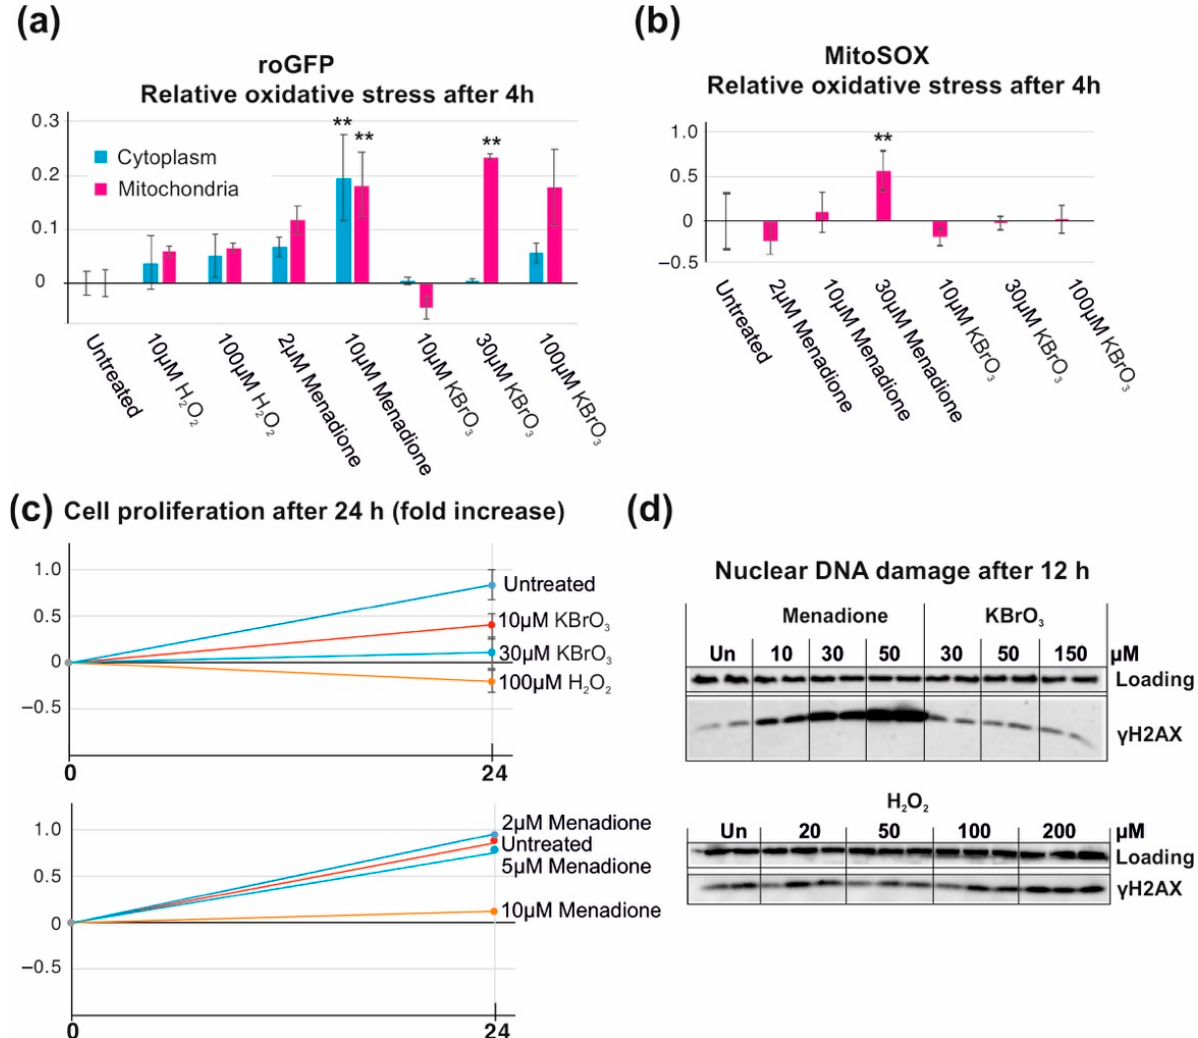
Figure 1. Oxidative stress, nuclear DNA damage, and cell proliferation after menadione, KBrO 3 , and H 2 O 2 exposure. ( a ) Cytoplasmic and mitochondrial oxidative stress in HEK293T cells measured as a relative change in the roGFP fluorescence intensity after 4 h treatment with different oxidant concentrations. Measurements normalized against the untreated samples (0-fold change). ( b ) Mitochondrial superoxide levels in HEK293T cells after 4 h treatment with different oxidant concentrations. Measurements normalized against the untreated samples. ( c ) Cell proliferation measured as fold increase in cell number during 24 h exposure to different oxidant concentrations. Only selected concentrations shown to demonstrate the effective range of the chemicals. ( d ) Activation of nuclear DNA damage signaling—phosphorylation of histone H2AX ( γ H2AX)—in HEK293T cells after 12 h treatment with different oxidant concentrations. ** p < 0.01 ANOVA/Tukey, compared with the untreated control. Minimum of three replicates each. Vinculin was used as loading control for the Western blots.